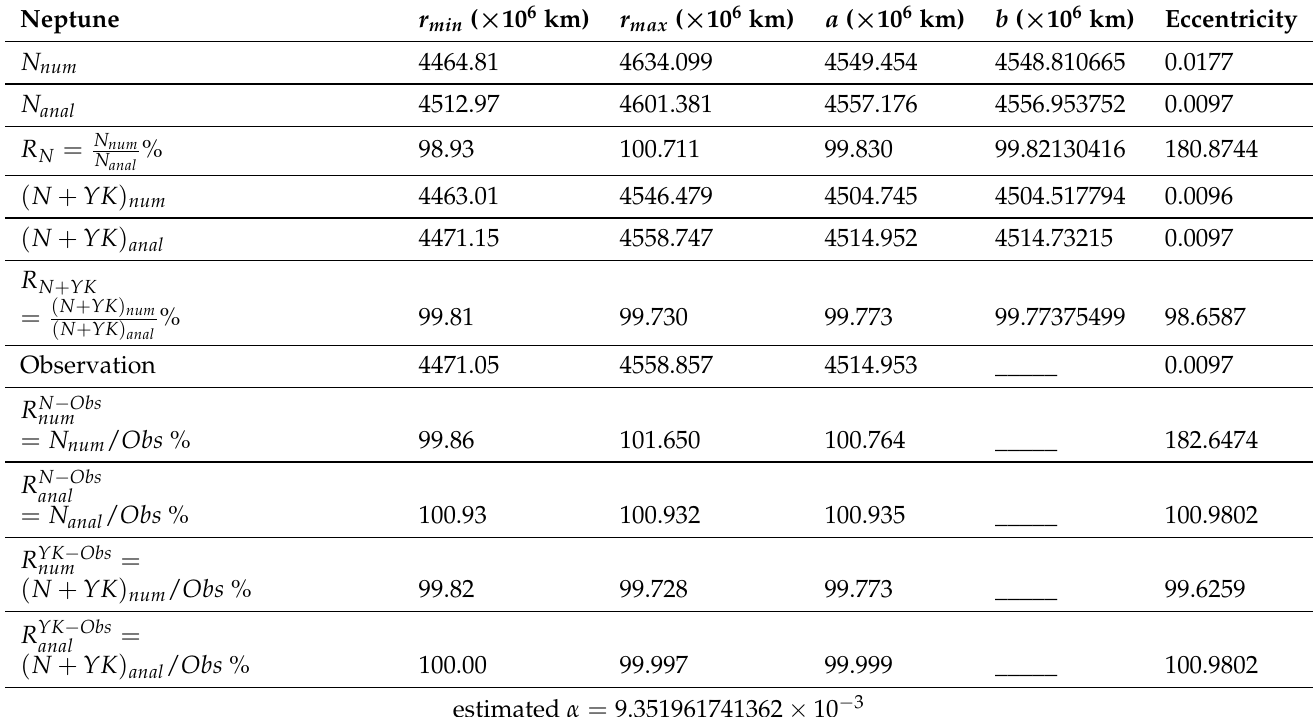
Table A16. The values of the calculated and observational astronomical parameters, for estimated α , of the planet Neptune, whose number of moons is 0.